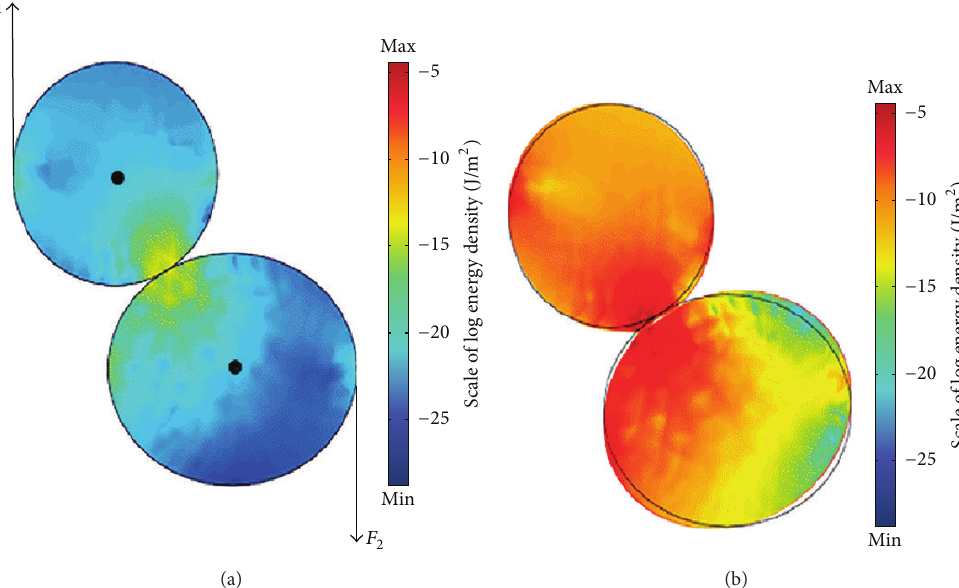
Figure 15: Deformation of two contacting ellipsoidal particles at change in relative angle position of major axle: 𝜑 = 0.001 (a) and 0.1 (b). Color (bottom-up) means the logarithm of the elastic energy density.